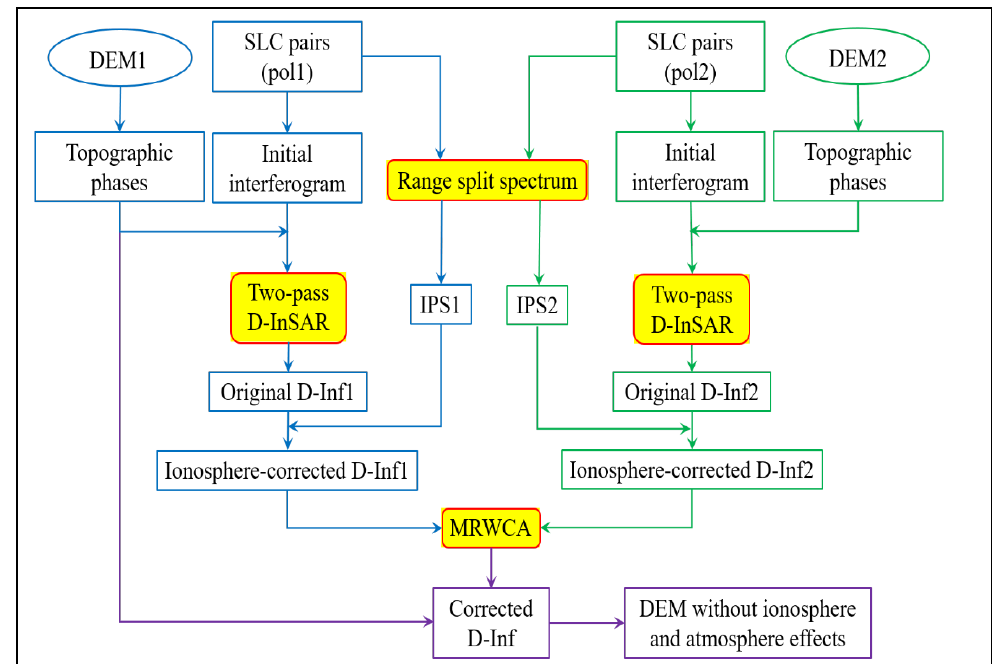
Figure 1. The workflow of the proposed method for correcting the ionospheric artifacts and atmospheric effects of interferograms and generating the interferometric synthetic aperture radar (InSAR) digital elevation model (DEM). IPS = ionosphere phase screen; D-Inf = differential interferogram.